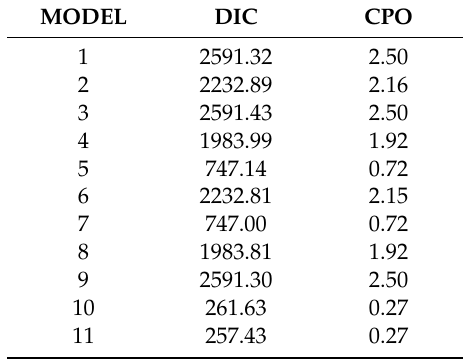
Table 3. Deviance information criterion (DIC) and conditional predictive ordinate (CPO) of models (for PM 2.5